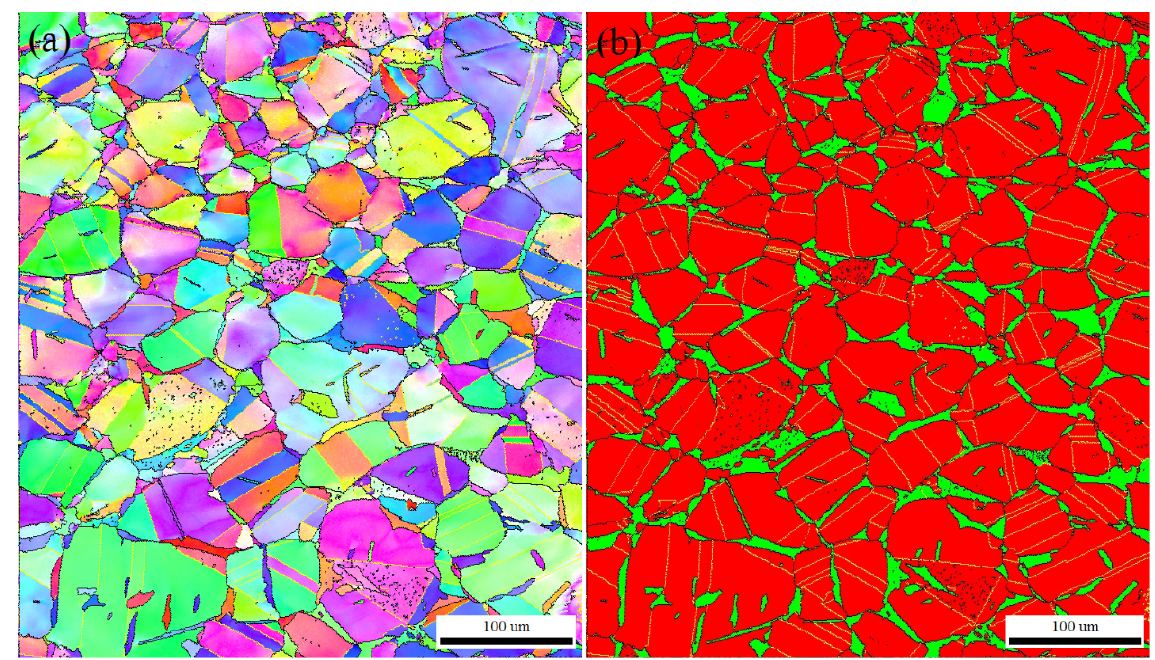
Figure 4. ( a ) IPF and ( b ) phase maps of the double-phase sample. The red and green colors in phase map refer to α and β phases, respectively.